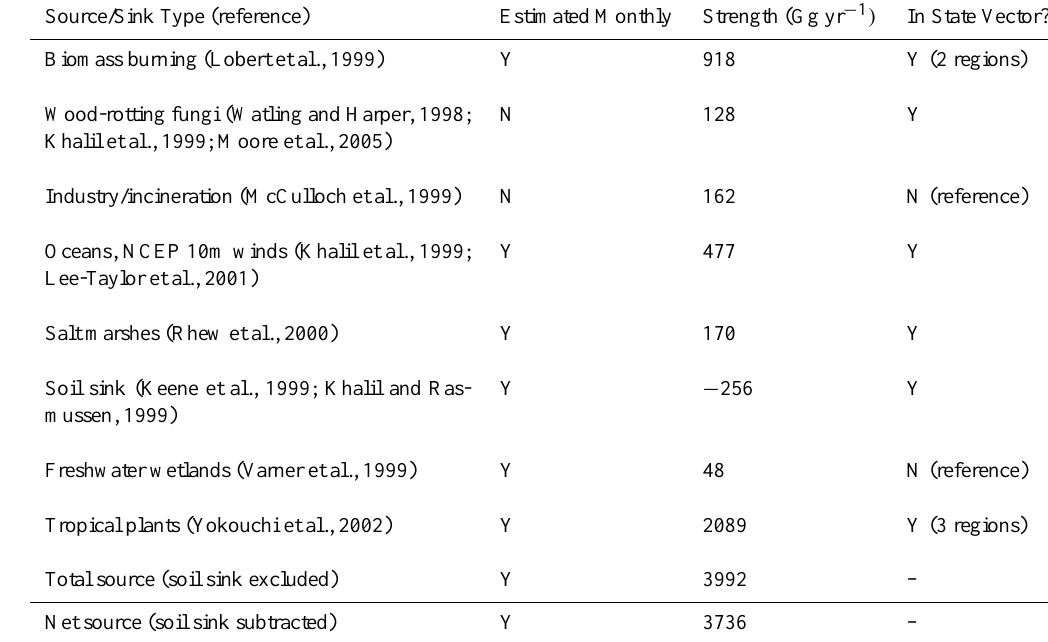
Table 2. Reference annual average strengths of the sources and sinks of CH 3 Cl and their incorporation in the inversion. Y=YES and N=NO. Source/Sink Type